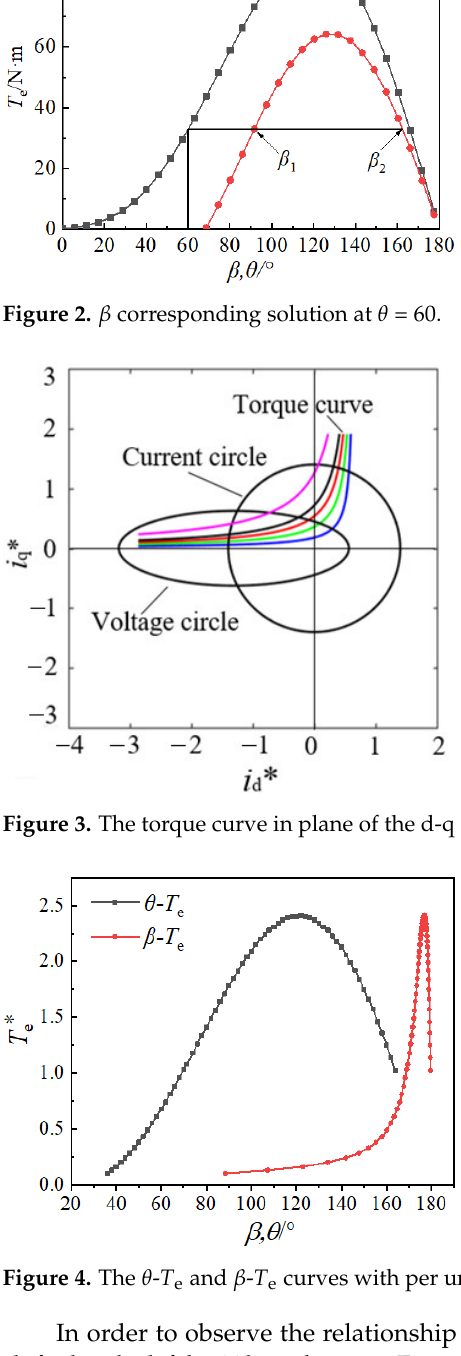
Figure 4. The θ-T e and β-T e curves with per unit value.